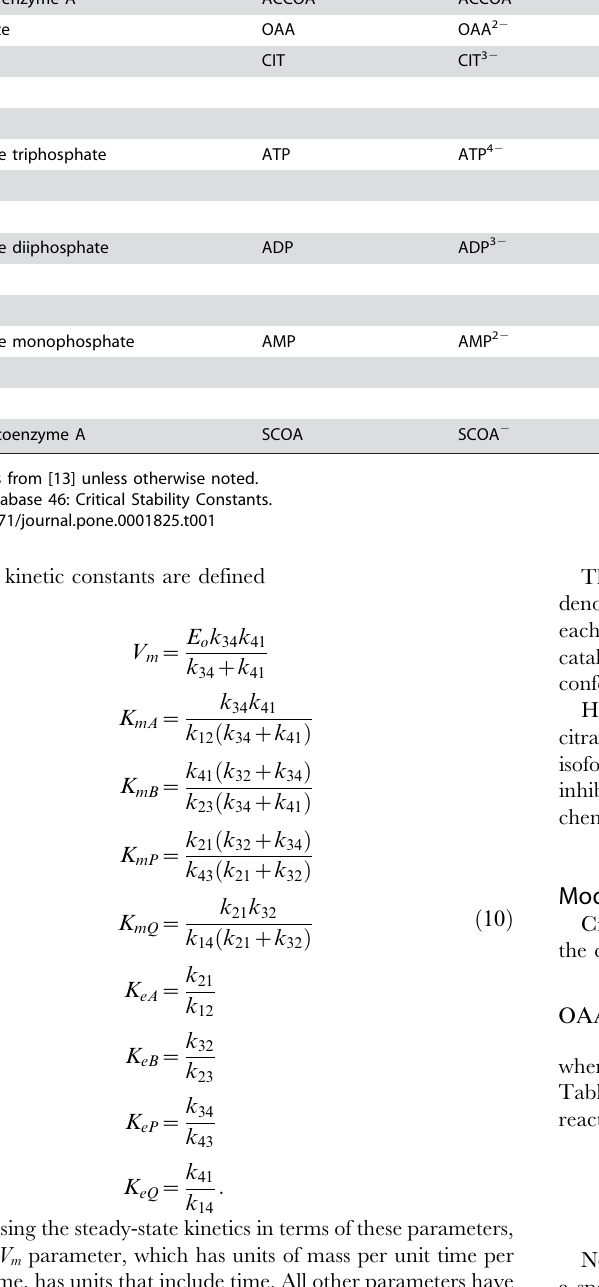
Reactant Abbreviation Reference species